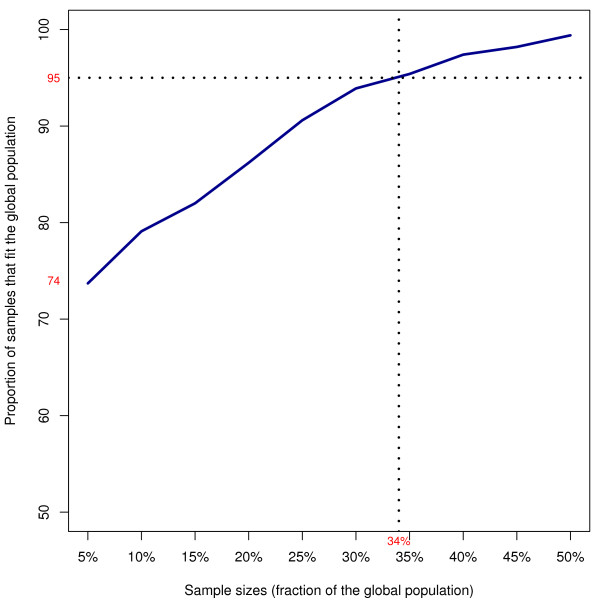
Proportion of samples that correctly represents the total set of articles when the sample size is growing. Eight parameters were tested both over the total set and over the samples. The probability of drawing a correct sample is 95% when the sampling size is 34% of the global population.